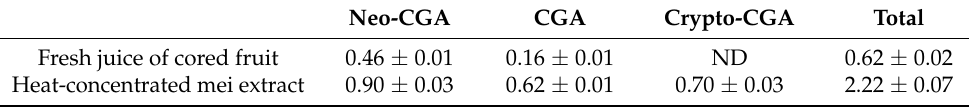
Table 1. Quantification of chlorogenic acid isomers in fresh juice of Prunus mume fruit (cored), and heat-concentrated mei extract. Data are presented as mean ± SEM ( n = 3) milligram per gram of juice or mei